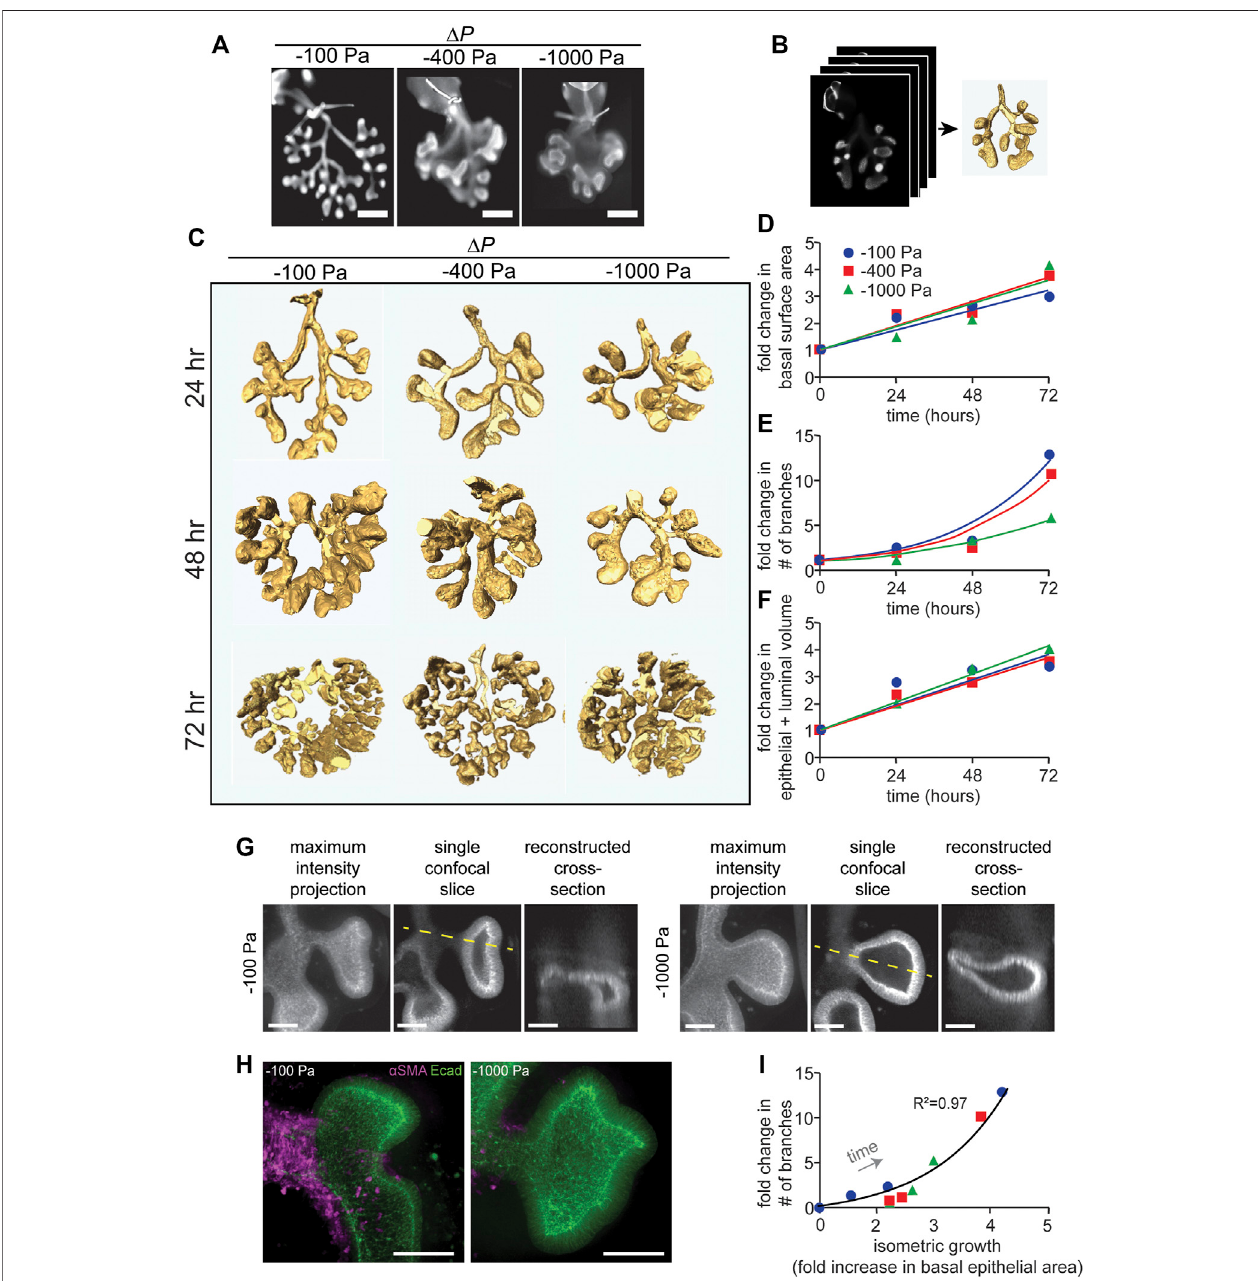
FIGURE 2 | Quantitative morphometric analysis of the effects of negative transpulmonary pressure on airway branching. (A) Immuno fl uorescence analysis for E-cadherin in lung explants that were maintained for 72 h at the indicated transpulmonary pressures. The trachea (with occluding suture) is evident at the top of each image. Scale bars, 250 µm. (B) Schematic of procedure to obtain 3D volume renderings of the airways. Confocal stacks of E-cadherin-stained lungs were used to generate3Dsolidmodelsoftheairways. (C) 3Dvolumerenderingsoflungsmaintainedat Δ P of − 100, − 400,and − 1,000 Pafor24,48,and72 h.Renderingsareto scale. (D – F) Graphs of fold-change in (D) the basal epithelial surface area of the airways, (E) the number of branches, and (F) the volume of the airways (inclusive of the lumen) as a function of time and transpulmonary pressure. (G) Maximum intensity projections, single confocal slices, and reconstructed cross sections (taken along the dashed yellow line) of explants held under Δ P of − 100 or − 1,000 Pa and stained for E-cadherin. (H) Immuno fl uorescence analysis for E-cadherin (green) and α SMA (magenta) in lung explants that were maintained for 24 h at the indicated transpulmonary pressure. Scale bars, 50 µm. (I) Relationship between allometric growth (branching) and isometric growth (basal epithelial surface area) as a function of time and transpulmonary pressure. Points indicate experimental measurements; lines indicate linear and exponential curve fi ts to the data (N (cid:1) 3 experimental replicates).